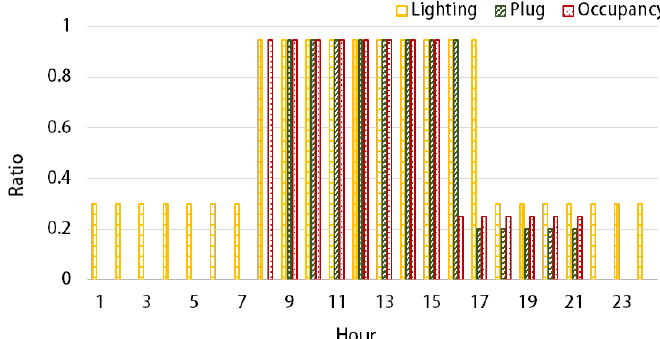
Figure 8. Occupancy, lighting, and equipment schedules of the school building. Table 3. Summary of the school.